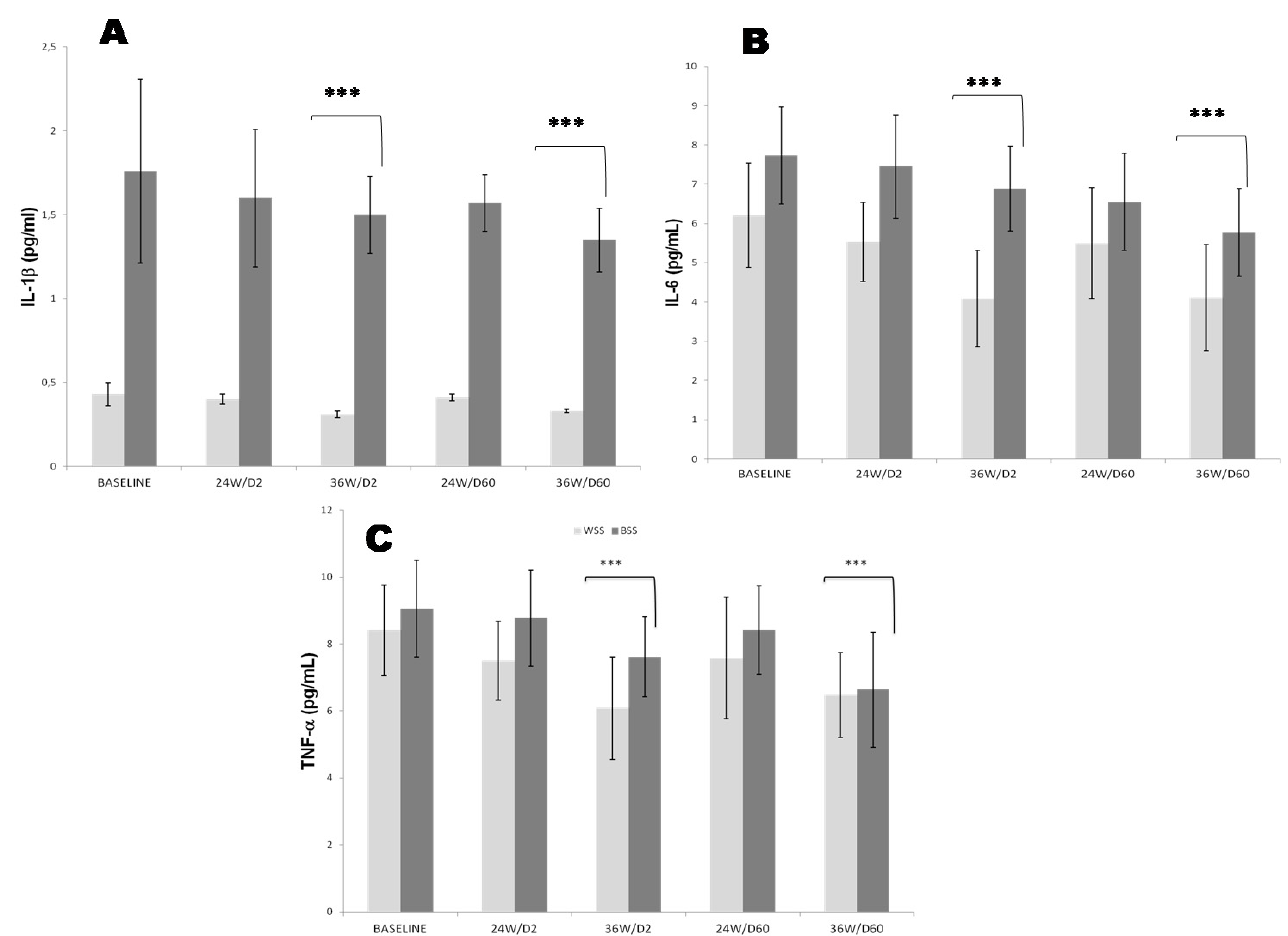
Figure 2. Effects of oral 2000 IU/day and 60,000 IU/month vitamin D 3 supplementation on plasma C: TNF- α (tumor necrosis factor- α ), ( A ): IL-1 β (interleukin-1 beta) and ( B ): IL-6 (interleukin-6) in CKD White and Black SS people at 2000 IU doses every day (D2 group) versus 60,000 IU doses every month (D60 group) during 24 and 36 weeks vitamin D 3 treatment. The mean values are assigned from the standard error to the mean (X ± ESM). The degree of significance is calcu-